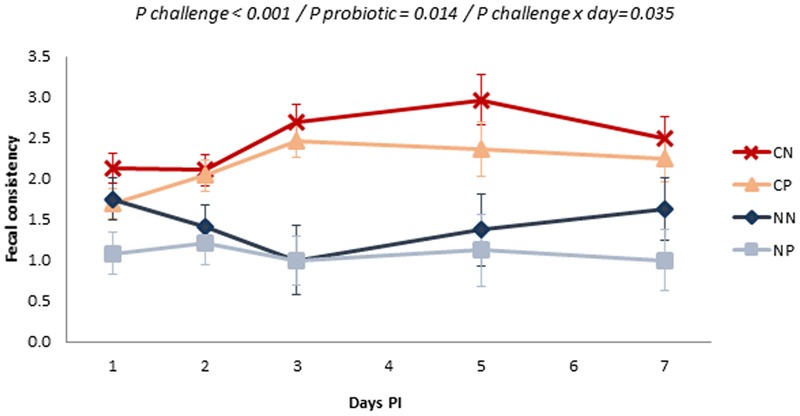
Evolution of the mean fecal scores in the different experimental groups along the post-inoculation (PI) period. Fecal score was measured using a scale from 1 (solid and cloddy) to 4 (watery or with blood). Treatments: CN, challenged + no probiotic; CP, challenged + probiotic; NN, no challenge + no probiotic; NP, no challenge + probiotic. n = 8 for groups CN and CP, n = 4 for groups NN and NP. P-values only included when significant. Bars represent the standard error of the LS-Means.